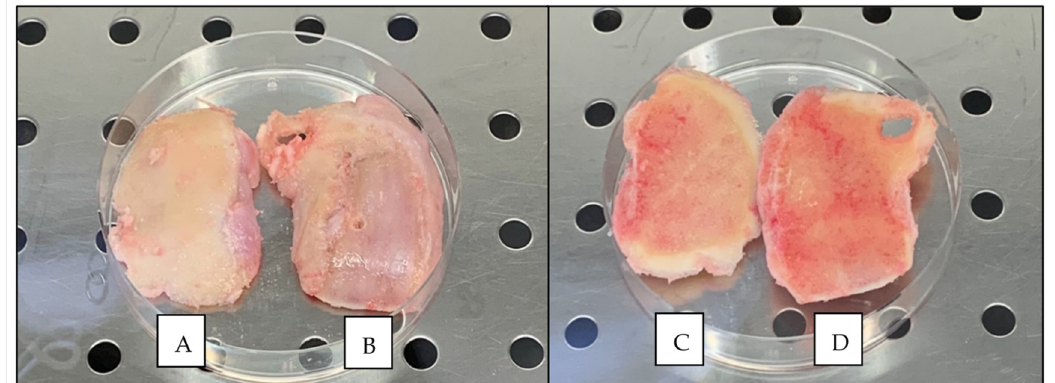
Figure 4. Example of the macroscopic appearance of knee condyles collected from one patient following TKR surgery. ( A ) Condyle with the best (lowest) ICRS graded cartilage (cartilage side). ( B ) Condyle with the worst (highest) ICRS graded cartilage (cartilage side). ( C ) Condyle with the best ICRS graded cartilage (bone side). ( D ) Condyle with the worst (highest) ICRS graded cartilage (bone side). Note that cartilage is eroded down to the bone in the worst graded condyle ( B